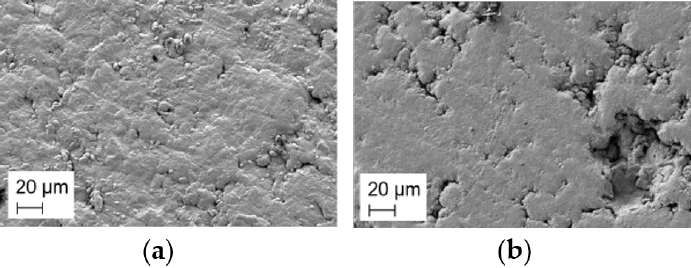
Figure 31. SEM observations of Mo coating produced with HIPIMS on MoGr ( a ) and graphite ( b ). Note how the coating replicates the substrate features, producing